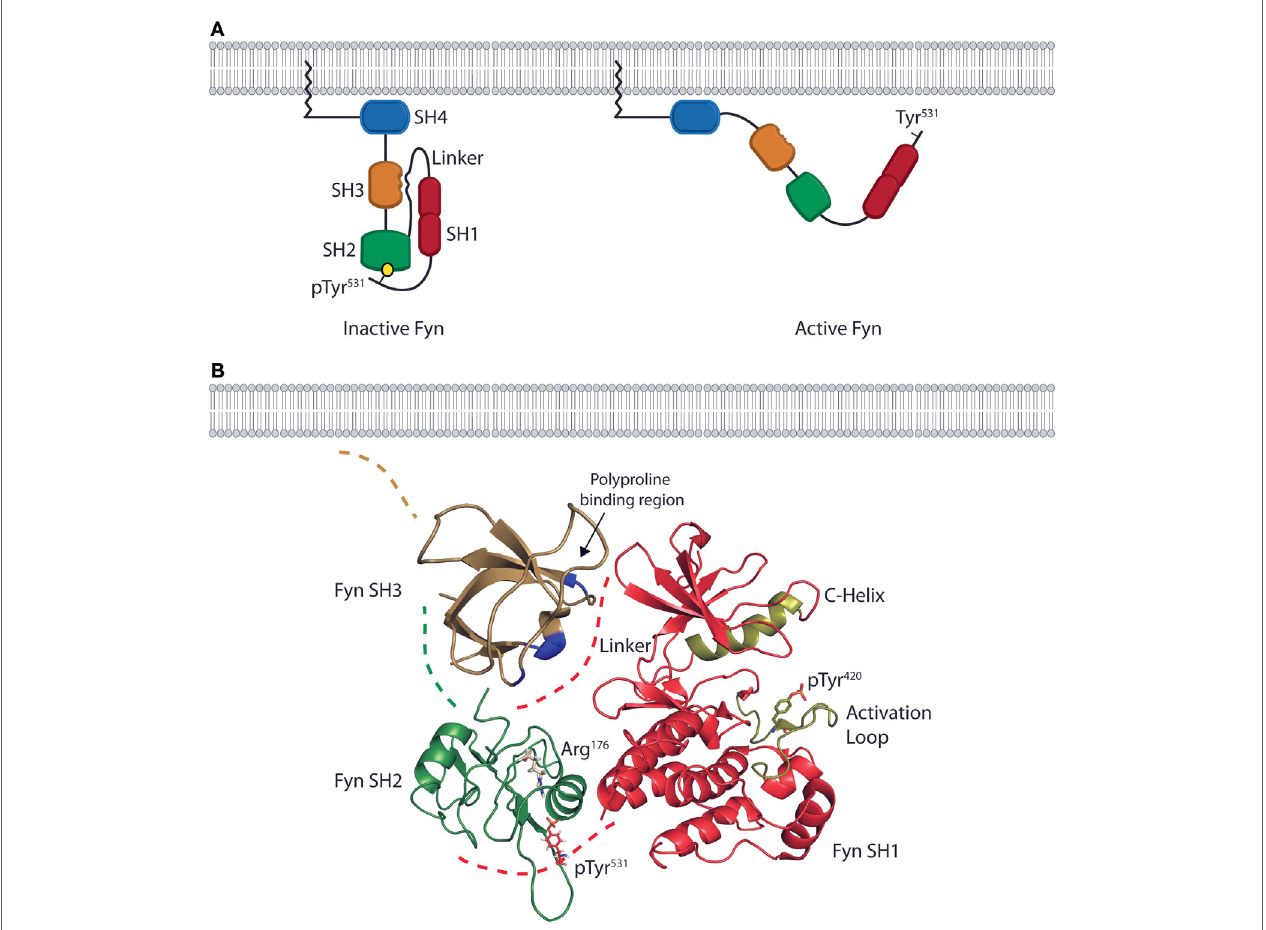
FiGURe 1 | The domain structure and intramolecular interactions of the Fyn kinase . (A) Models of the two primary conformations of the Fyn kinase. The domain structure of Fyn consists of four SH domains. The relative positions of the domains are shown in both the inactive (left) and active (right) states. The N-terminal SH4/unique domain (blue) lies proximal to the membrane-anchoring myristoylation site. The SH4 domain is followed by the SH3 (gold) and SH2 (green) domains responsible for mediating interactions between Fyn and its target substrates. These domains are followed by a linker region that connects the SH2 domain to the bilobal SH1/kinase domain (red) responsible for enzymatic activity. The inactive form of the kinase is kept in a closed conformation by intramolecular interactions between the SH2 domain and a C-terminal phosphotyrosine as well as by an interaction between the SH3 domain and a polyproline helix in the linker region (left). The active conformation is adopted upon disruption of these interactions and opening of the kinase. In the active conformation, the SH2 and SH3 domains mediate protein–protein interactions, while the kinase domain phosphorylates downstream effectors (right). (B) Ribbon diagrams of the SH3, SH2, and SH1 domains show their relative positions in the inactive conformation. Positions are based on the structure of auto-inhibited Src (PDB deposition 2SRC), which has an identical domain arrangement. The blue high-lighted area of the SH3domain is the site of interaction with the linker region. The SH2 domain of Fyn (green) possesses an Arg residue in the second β -sheet (Arg β B5, Arg 176 ) that is conserved across SFK family members. This Arg residue is the primary site of interaction with the phosphotyrosine on target substrates. In the inactive conformation, Arg 176 is bound to the C-terminal inhibitory pTyr 531 of Fyn. These intramolecular interactions place the SH2 and SH3 domains in a position to occlude the kinase domain (red) from substrate binding, thus preventing phosphate transfer. The ribbon diagram of the kinase domain is derived from PDB deposition 2DQ7, and the positions of the C-Helix and activation loop (gold) show the structure of the Fyn kinase domain complexed with staurosporine. To date, this is the only conformation of the Fyn kinase domain that has been characterized, and it is used here to demonstrate the intramolecular interactions that keep Fyn in an inactive state. The SH3 domain ribbon diagram is from PDB deposition 1NYG, and the SH2 ribbon diagram is from the PDB deposition 1AOT, and is representative of the SH2 domain bound to a phosphotyrosine-containing